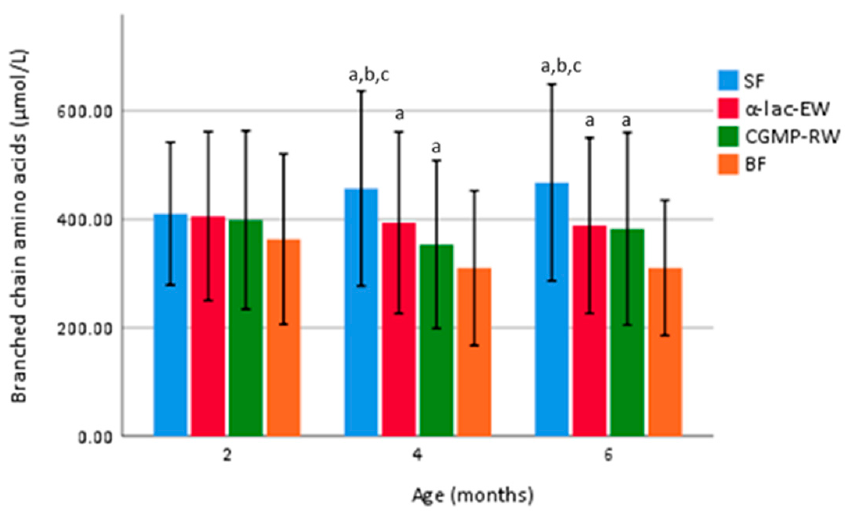
Figure 4. Mean ( ± SD) total BCCA (isoleucine, leucine, valine) plasma concentration in the random- ized subgroup (n = 50 in each group) at four and six months of age. Groups compared by one-way ANOVA, post hoc Bonferroni. p value < 0.05 are considered statistically significant and marked by superscript letters. a Significantly different vs. BF. b SF vs. α -lac-EW. c SF vs. CGMP-RW. SF, standard formula; α -lac-EW, experimental formula with α -lactalbumin enriched whey; CGMP-RW, experimental formula with reduced CGMP whey; BF,